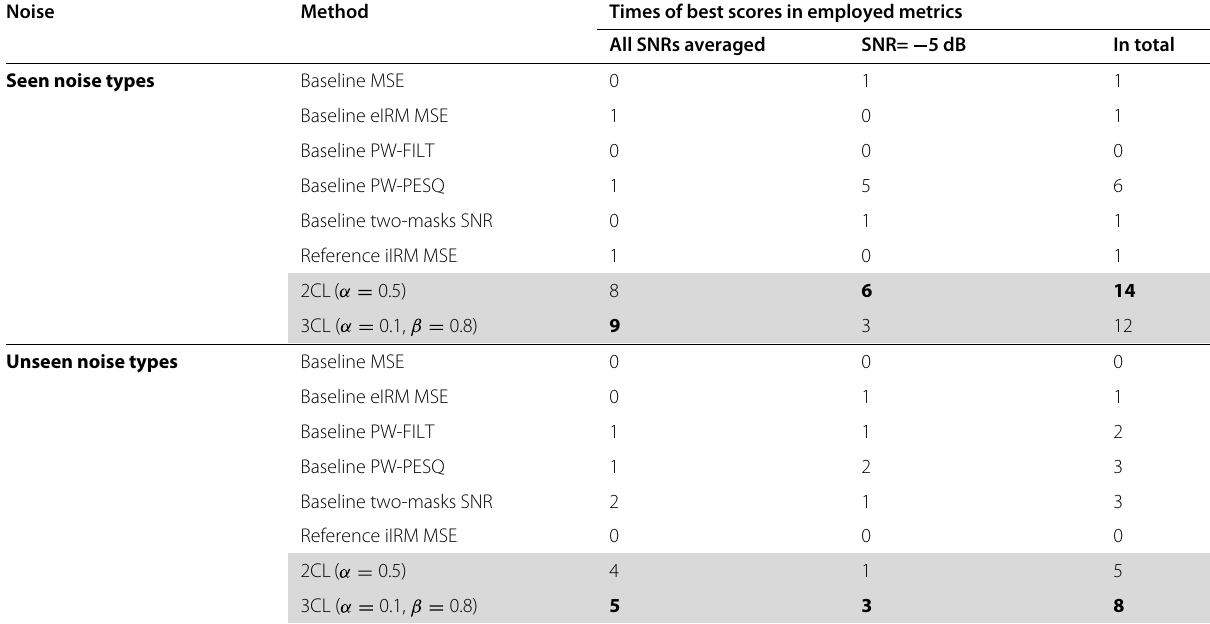
Table 10 Test set performance ranking for both seen noise types (PED and CAFE) and unseen noise types (BUS), based on how many times each loss function provides the best scores in all employed instrumental metrics. Best approaches from Tables 1 and 3 are gray-shaded; the best scheme is in boldface Noise Method Times of best scores in employed metrics All SNRs averaged Seen noise types